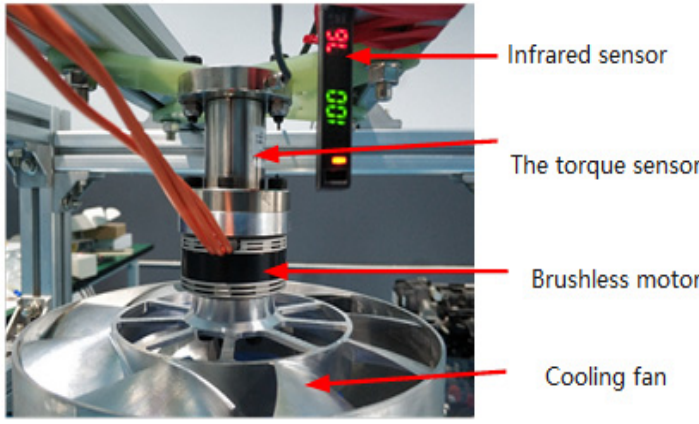
Figure 6. Connection structure of test bench.